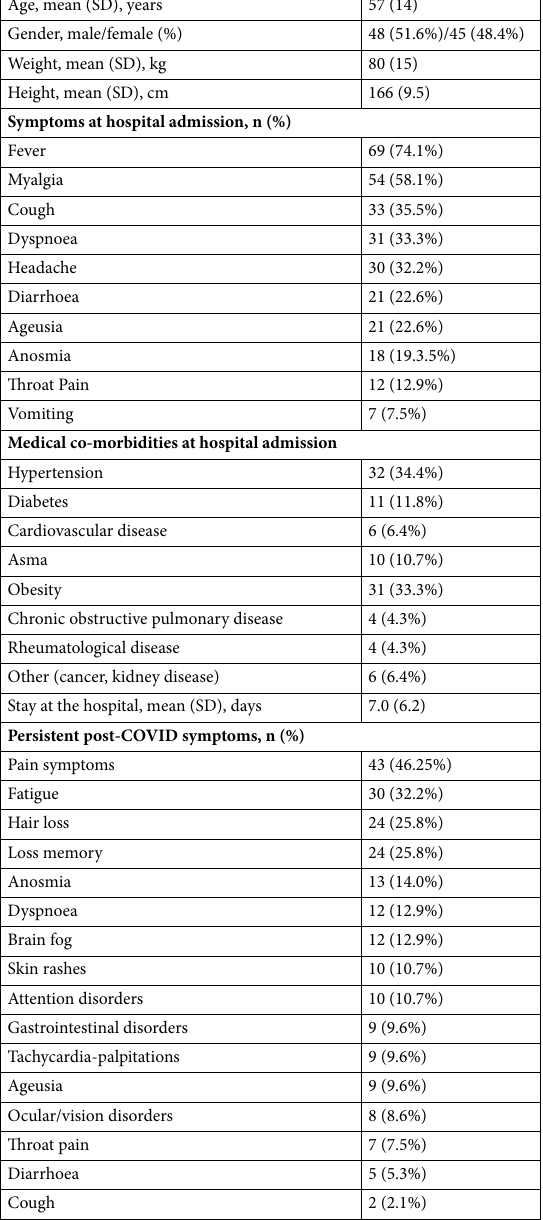
Table 1. Demographic and clinical data of the sample (n = 93).